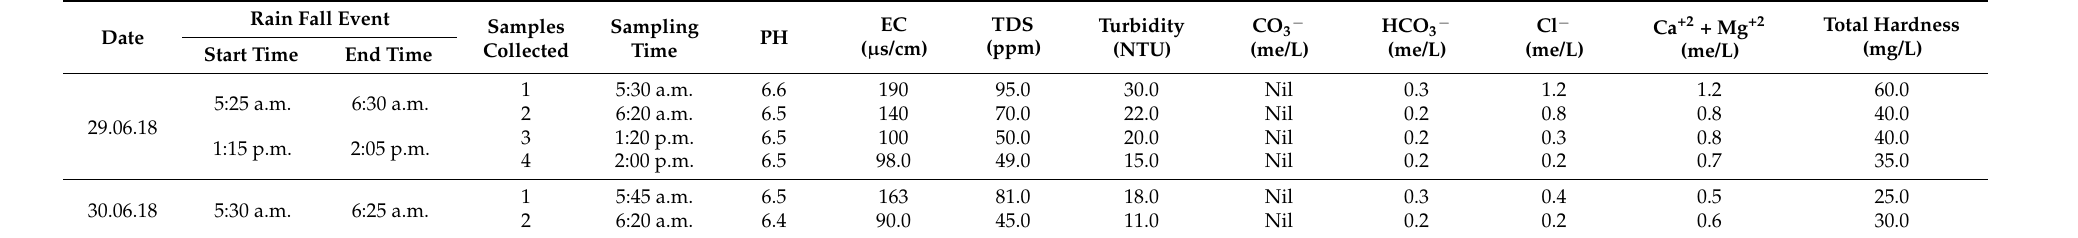
Table A11. Street run off rain samples collected from Site